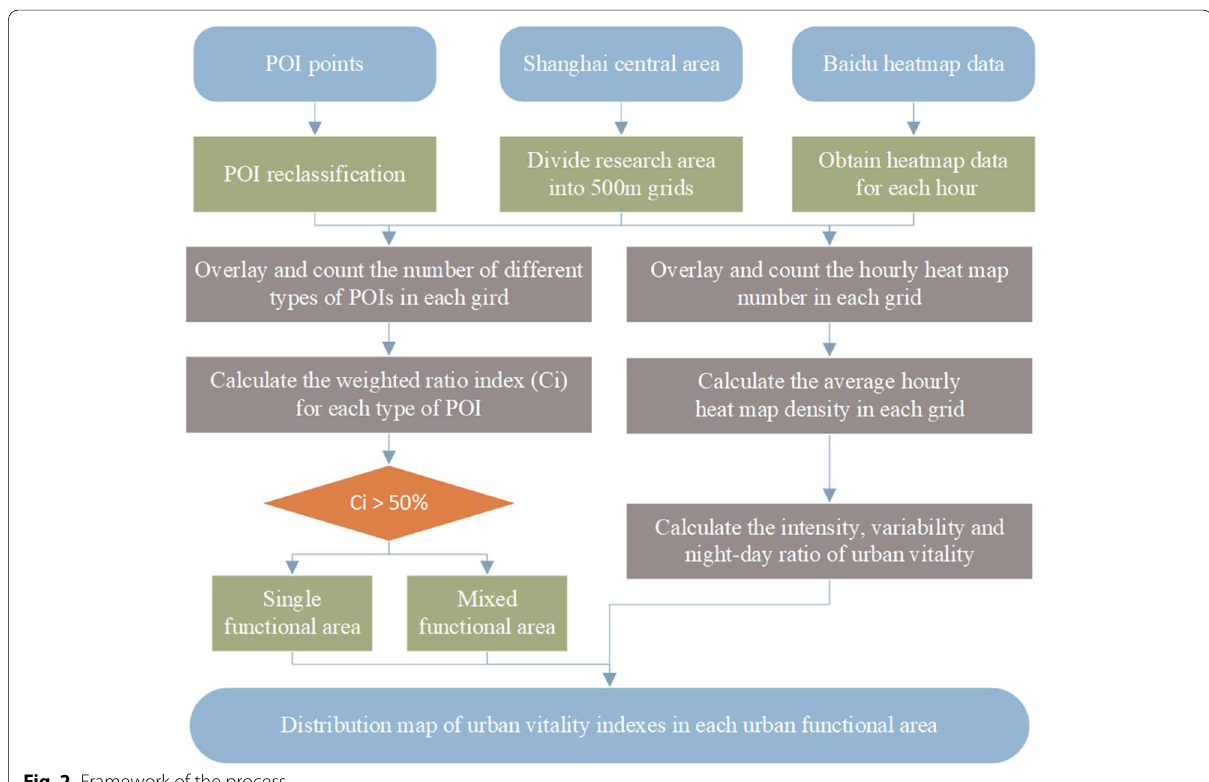
Fig. 2 Framework of the